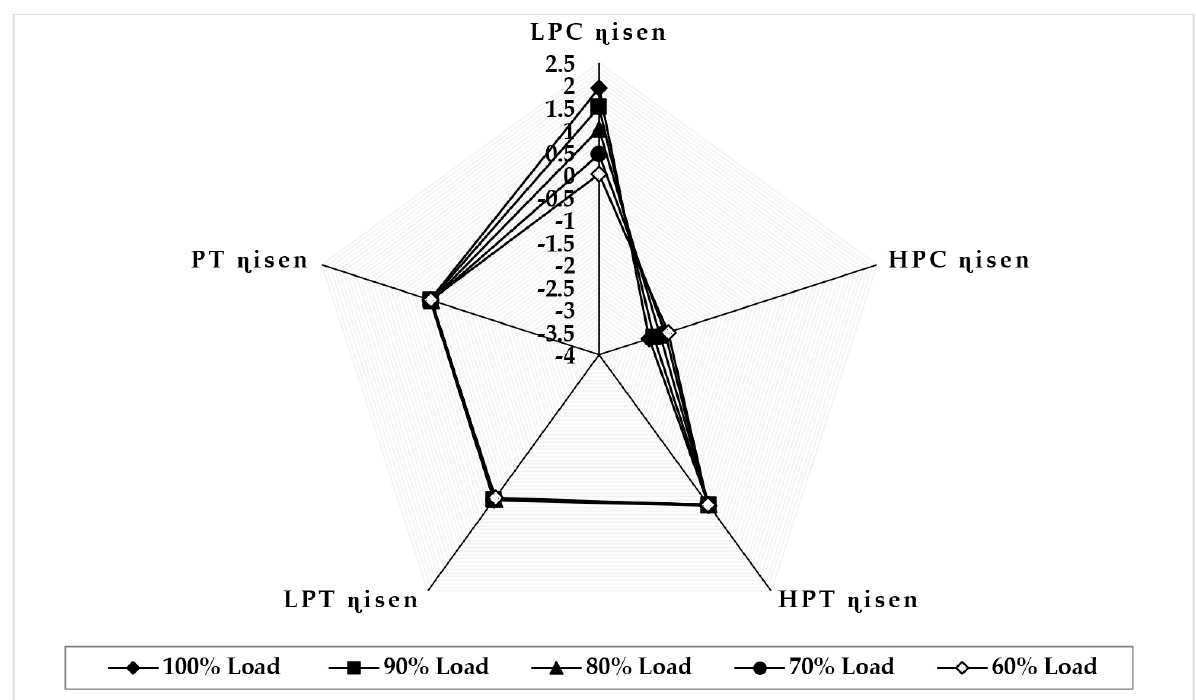
Figure 10. Deviation in component isentropic efficiency due to HPC erosion at 100% fault severity at full − load and part − load operation.